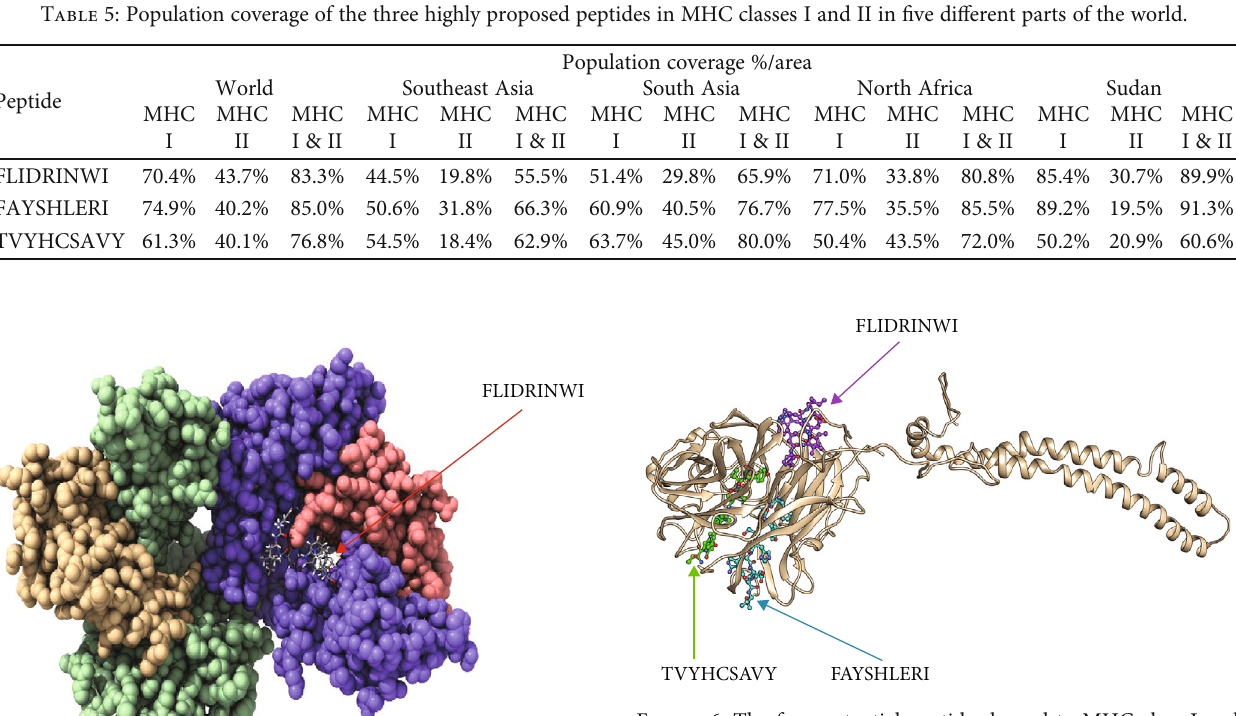
Figure 6: The four potential peptides bound to MHC class I and